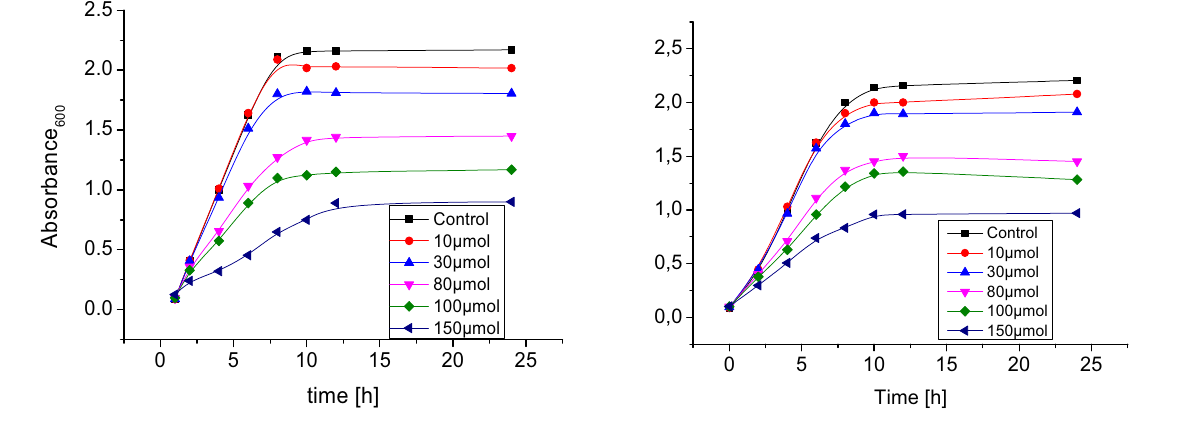
Figure 5: Growth curves of E. coli during the course of a 24 h culti - vation in the presence of 10; 30; 80; 100; and 150 μ mol of the complex 3